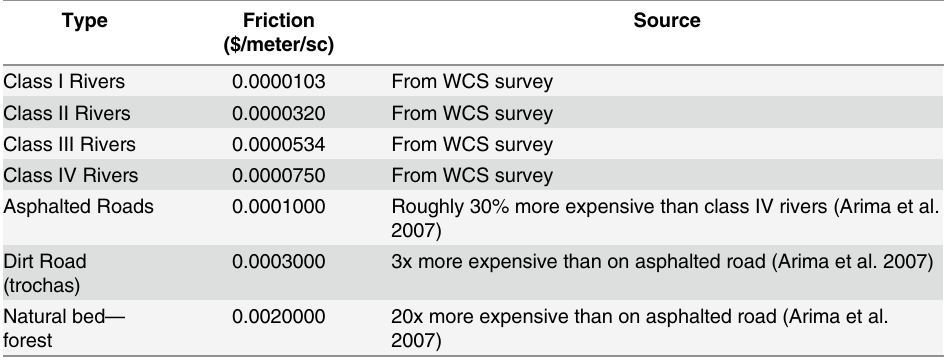
Table 2. Transportation costs according to different modes of transportation and infrastructure